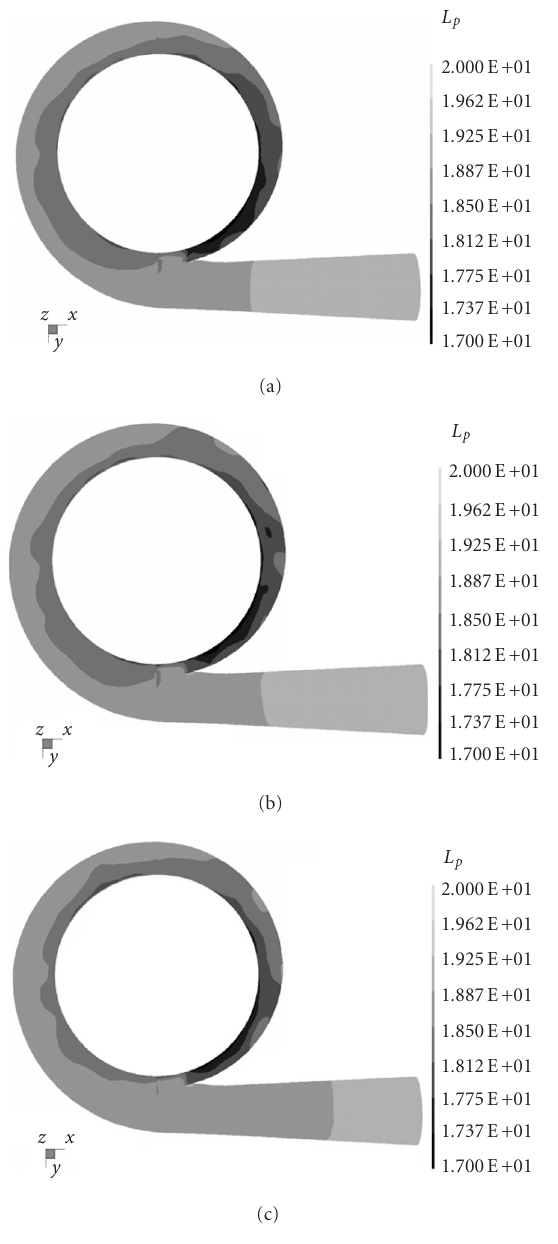
Figure 19: Static pressure on the volute surface for the vaneless case at design conditions: (a) starting position, (b) 1 / 3 revolution, and (c) 2 / 3 revolution.